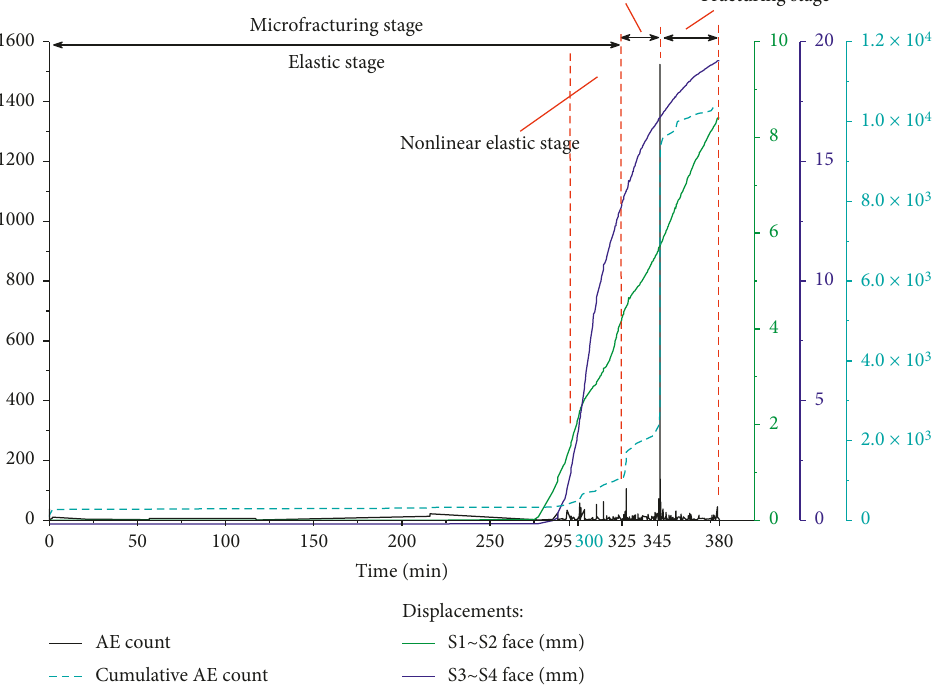
Figure 10: The relationships between displacement, AE event count, cumulative AE event count, and time before and after the fracturing of the layered concrete test